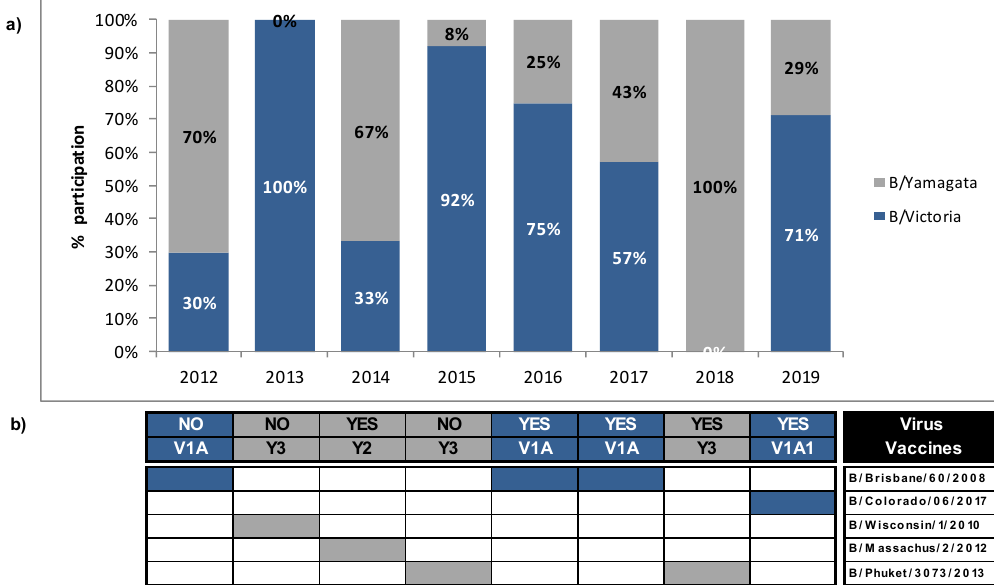
Figure 3. Circulation of influenza B lineages according to season (year) and recommended vaccine lineage, Uruguay, 2012 to 2019. ( a ) Circulation percentages of both lineages for each season based on samples that could be subtyped. Blue boxes represent B / Victoria lineage; grey boxes represent B / Yamagata lineage. ( b ) Vaccine strains used for each year are indicated, and “Yes” or “No” if they coincide with the influenza B strains that have circulated. Abbreviations V1A, V1A1, Y2, and Y3 correspond to clade 1A of B / Victoria lineage, subclade 1 of B / Victoria clade 1 A lineage, clade 2 of B / Yamagata lineage, and clade 3 of B / Yamagata lineage, respectively.